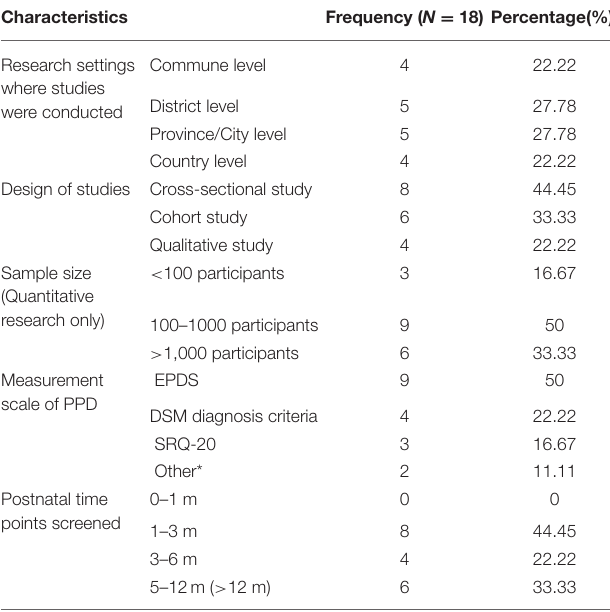
TABLE 2 | Characteristics of articles about postpartum depression in Vietnam published from 2010 to 2020.